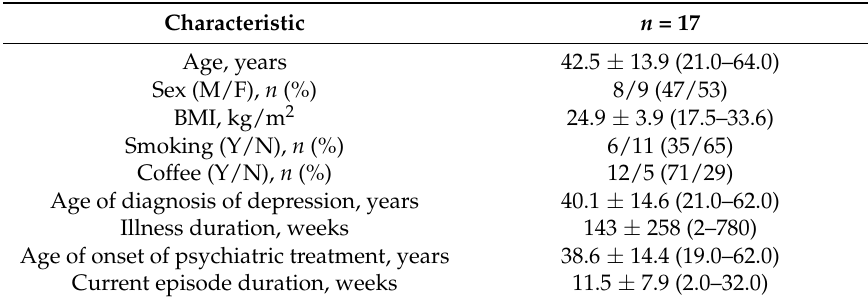
Table 2. Clinical characteristics of patients included in the